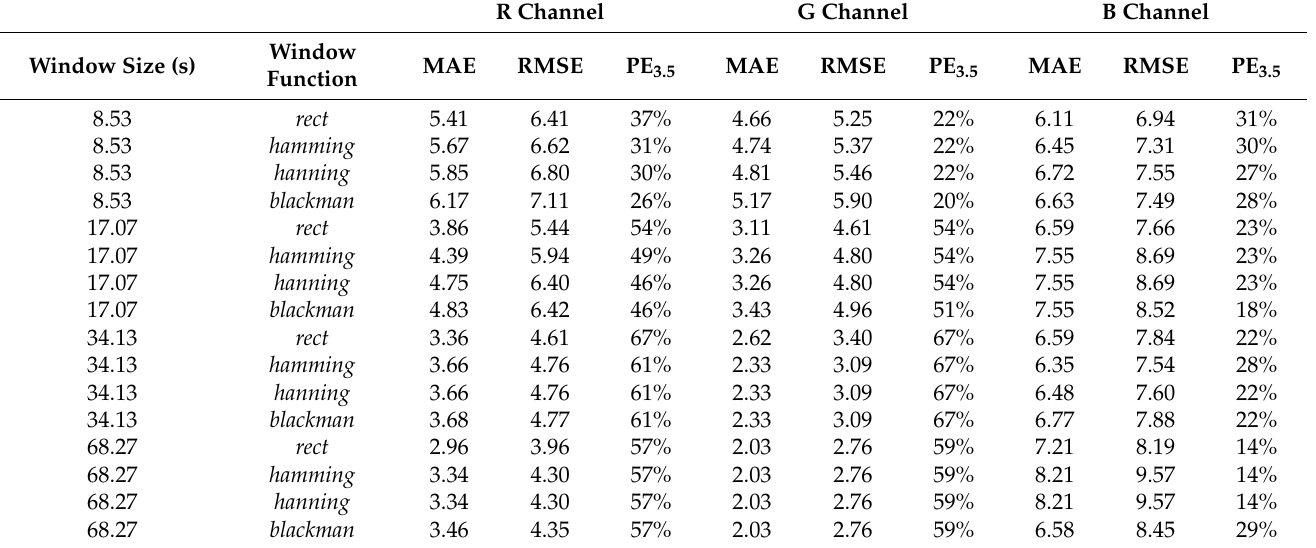
Table 1. Validation results of different window sizes (anaesthetized pig) and the three RGB channels presented as mean absolute error (MAE), root mean square error (RMSE) and percentage of heart rate (HR) error below 3.5 beats per minute when compared to the gold standard.